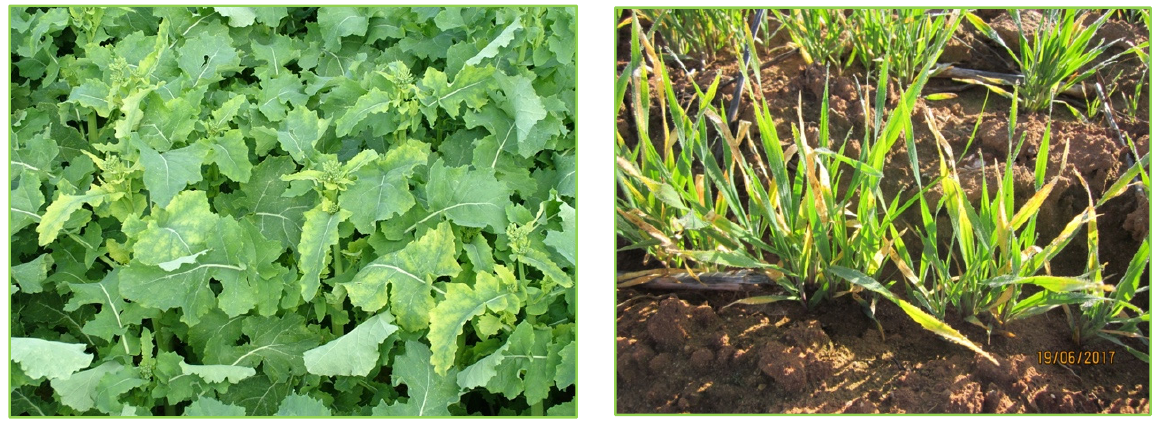
Figure 4. Seasonal Mn toxicity in canola and wheat field-crops in southeastern Australia (Photo: D. Eksteen 2017).